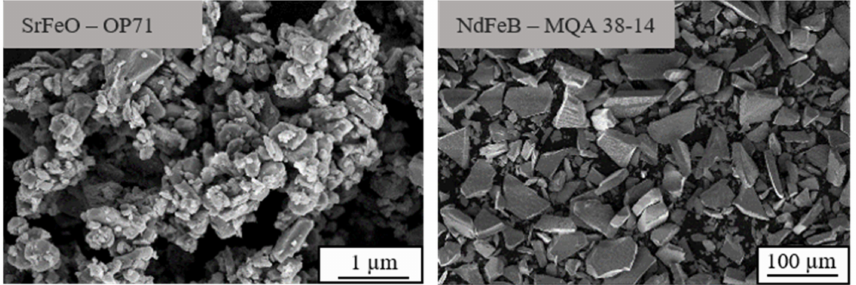
Figure 2. Particle geometry of anisotropic SrFeO and NdFeB using a scanning electron microscope.